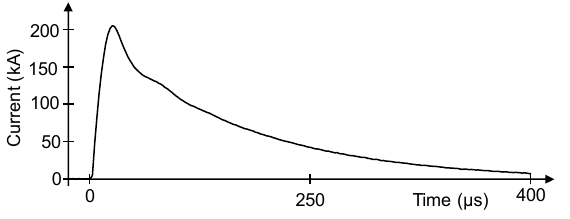
Figure 10. Example for high-current component A produced with the tandem generator at the University of the Federal Armed Forces Munich [1].